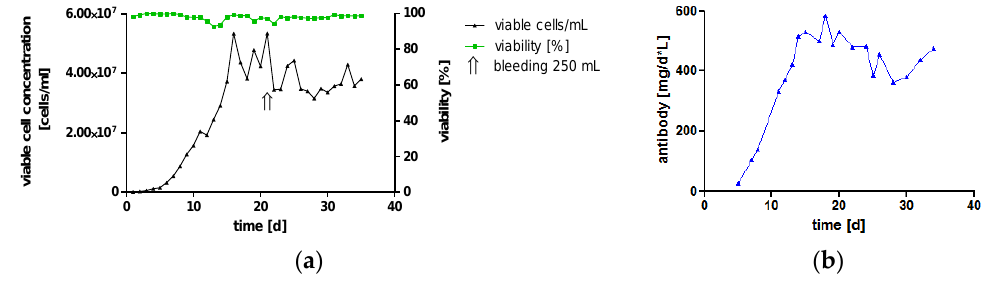
Figure 2. hTM IgA2 was produced in high yield by a perfusion process in a bioreactor. The working volume was 1 L using a 2 L stirred tank bioreactor. A Centritech was used for supernatant harvest and cell retention. ( a ) Viable cell concentration (black) and viability (green) during the 35-day process is shown. To maintain cell concentrations blow 5 × 10 7 viable cells/mL, 250 mL were removed once from the bioreactor (indicated by arrow). ( b ) Productivity (blue) was calculated based on titer enzyme-linked immunosorbent assays (ELISA) values multiplied by the perfusion rate and the working volume.